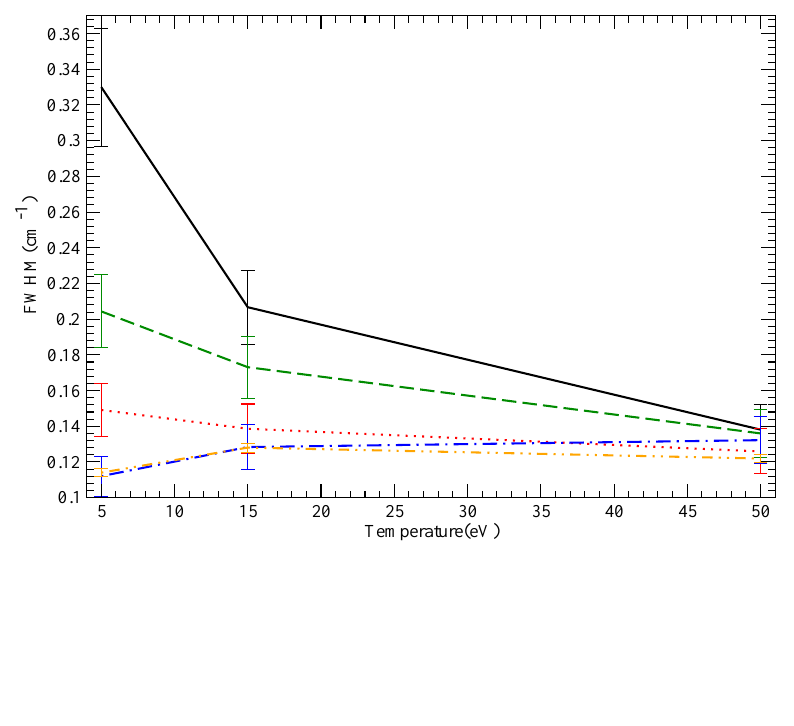
A comparison of hyperbolic and straight line trajectories for the NV 2s-2p transition widths, as computed by SCP-hyperbolic (solid black), SCP-straight (dotted red), SimU-hyperbolic (dashed green), SimU-straight (dash-dotted blue) and Simulation (dash-double dotted